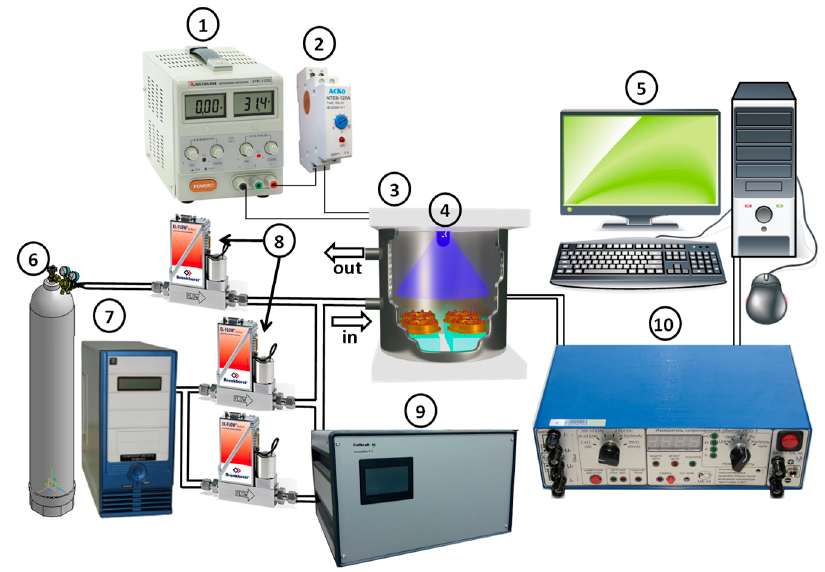
Figure 2. Schematic illustration of sensor measurements setup. (1) DC power supply QJ2002C (Ningbo JiuYuan Electronic, Zhejiang, China); (2) Time relay REV-114 (Novatek-Electro, Moscow, Russia); (3) Teflon airtight and light-tight chamber (laboratory-made); (4) UV LED (SMD-5050 XML, Epileds Co. LTD, Taiwan, China); (5) Control PC; (6) Analyte gas bottle (4.6 ppm of HCOH in N 2 , certified gas mixture, Monitoring, Russia); (7) Pure air generator («Granat-Engineering» Co.Ltd, Moscow, Russia); (8) Mass Flow Controller EL-FLOW F-221M (Bronkhorst, Ruurlo, The Netherlands); (9) Humidifier Cellkraft P-2 (Cellkraft AB, Stockholm, Sweden); (10) electronic module providing